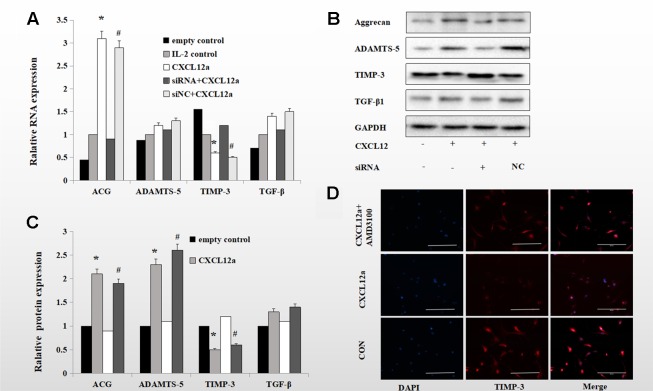
Blocking the CXCLL2/CXCR4 axis maintained IL-1-induced expression of TIMP-3 and aggrecan and enhanced expression of ADAMTS-5 and TGF-β1. (B) Primary chondrocytes were cultured in the presence of empty control, IL-2 control, CXCL12a (+,−), CXCL12a +siRNA CXCR4 (+,+) or CXCL12a + siNC (+NC) for 72 h and subjected to Western blotting of the protein levels of aggrecan, ADAMTS-5, TIMP-3, and TGF-β1. GAPDH served as the loading control (n = 4 per group). (C) Densitometric analysis. (A) Real-time PCR of aggrecan, ADAMTS-5, TIMP-3, and TGF-β1 mRNA levels in IL-1-induced primary cartilage treated with empty control (−,−), CXCL12a (+,−), CXCL12a +siRNA CXCR4 (+,+), or CXCL12a + siNC (+NC) for 24 h; *CXCL12a compared to empty control (p < 0.05); #siNC + CXCL12a compared to CXCR4 + CXCL12a siRNA (p < 0.05). (D) Primary chondrocytes were cultured in the presence of empty control, CXCL12a (250 ng/ml) or CXCL12a + AMD3100(20 μM) for 48 h. Immunofluorescence staining for TIMP-3; representative images are shown. TIMP-3 was visualized using a goat anti-rabbit IgG, and nuclei were stained blue by DAPI. Scale bar, 200 µm.